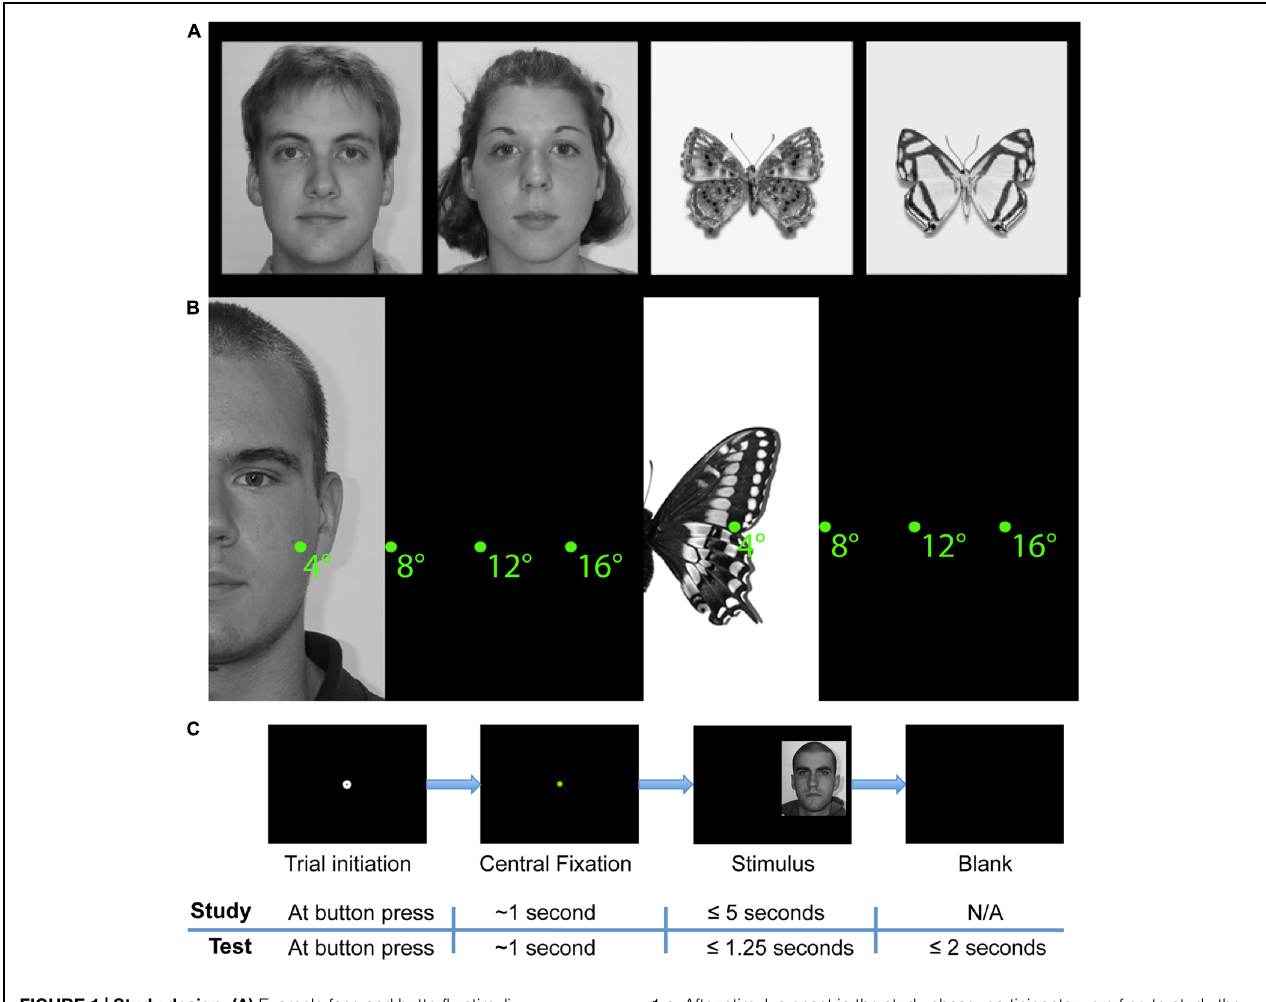
1 s. After stimulus onset in the study phase, participants were free to study the face for up to 5 s and pressed a button to begin the next trial. In the test phase, faces were presented for 1.25 s only and participants responded with button presses to indicate whether the stimulus was ‘old’ or